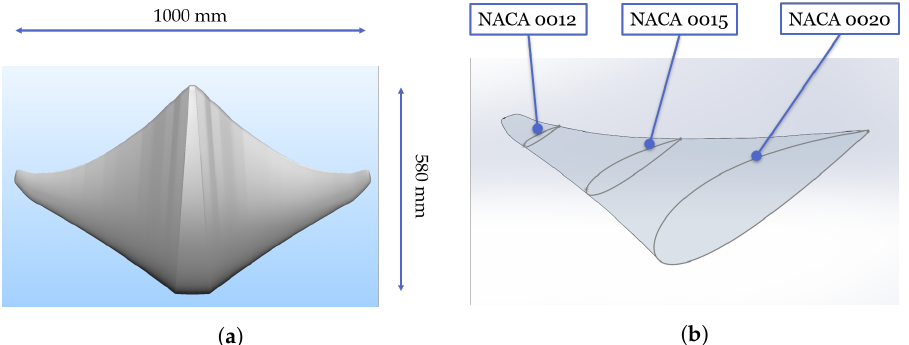
Figure 2. ( a ) Dimensions of the external surface of the robot and ( b ) cross sections of a fin.